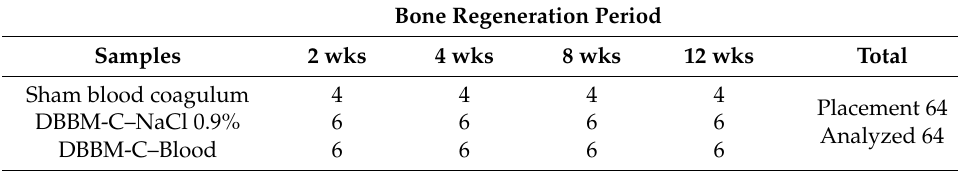
Table 1. Specimen